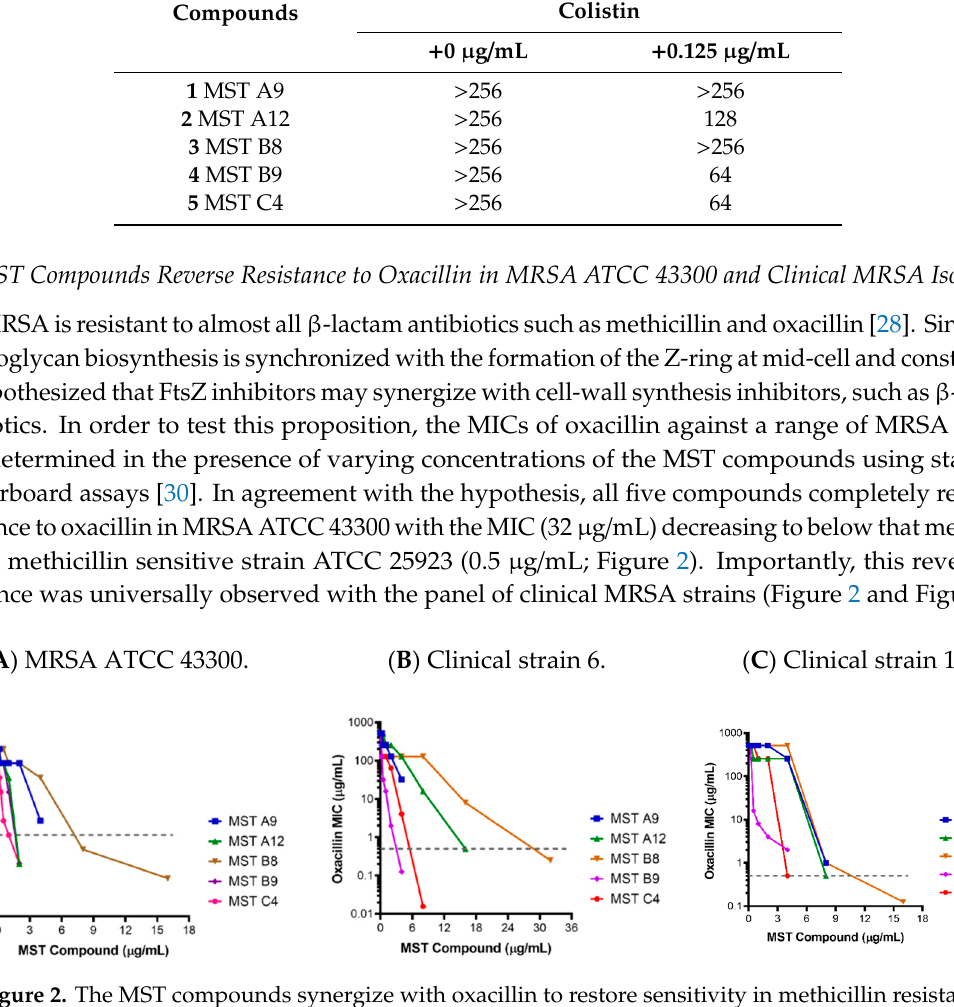
Table 2. Change in the MIC of MST compounds for E. coli ATCC 25922 in the presence of colistin. Compounds